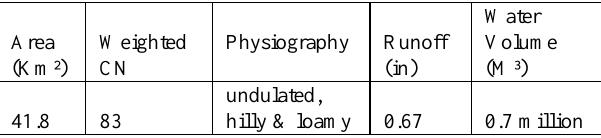
Table 4. Sub-catchment characteristics